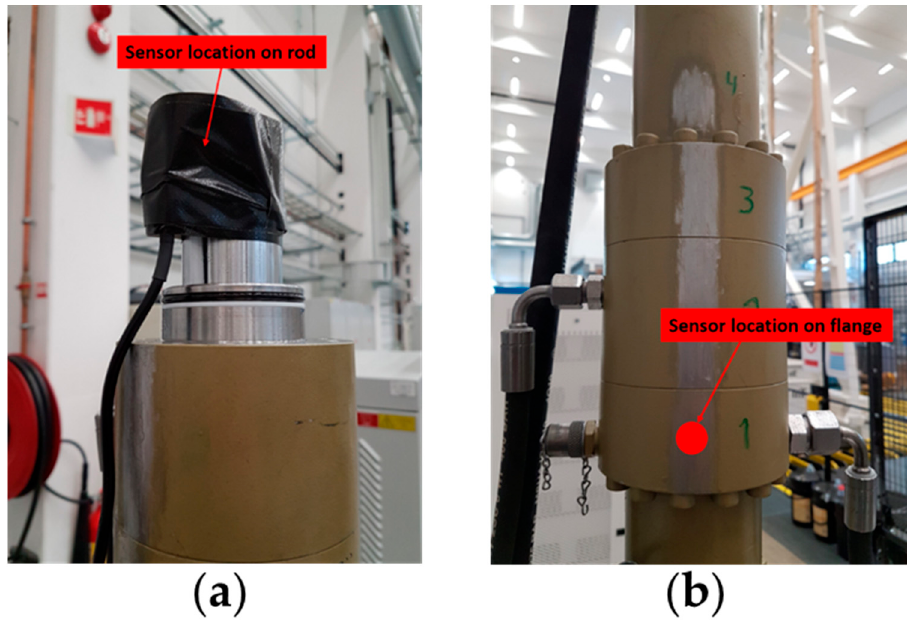
Figure 2. Sensor locations: ( a ) on rod (sensor mounted and secured with tape); ( b ) sensor location on the upper flange.